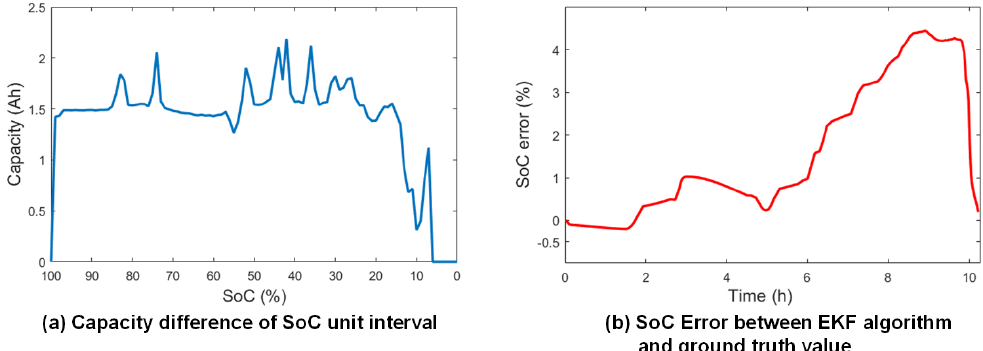
Figure 3. Comparison between capacity difference and SoC error: ( a ) Capacity difference of SoC unit interval; ( b ) SoC Error between EKF and the ground truth.